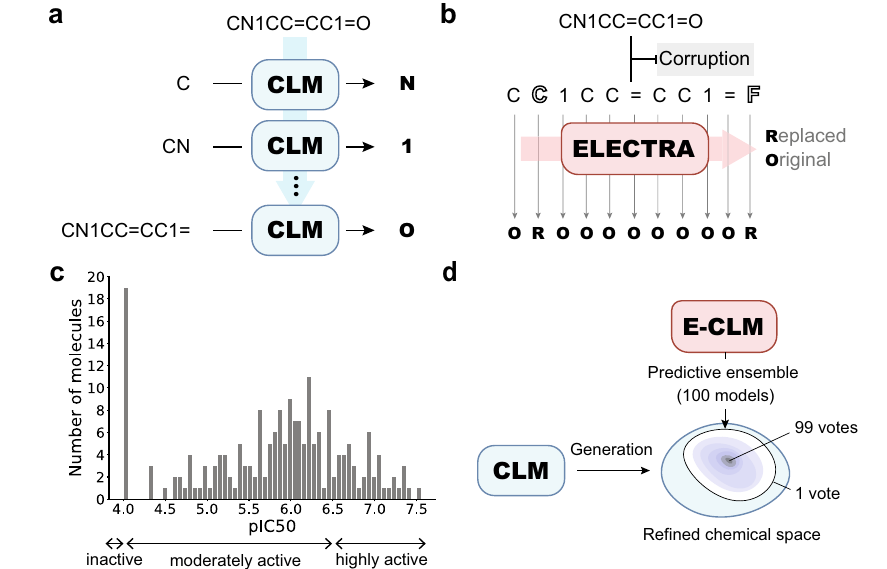
Fig. 2 | Bioactivity prediction. a A CLM for molecule generation iteratively pre- dicts the next character in a SMILES string given the preceding characters ( “ auto- regressive ” approach). b AnE-CLM(aCLMpretrainedwiththeELECTRAmethod)is trained on corrupted SMILES strings aiming to predict, for each string character, whetheritistheoriginal(correct)oracorrupted (substituted)character. c Activity distribution of the PI3K γ ligands. Compounds with annotated pIC 50 ≤ 4.0 were